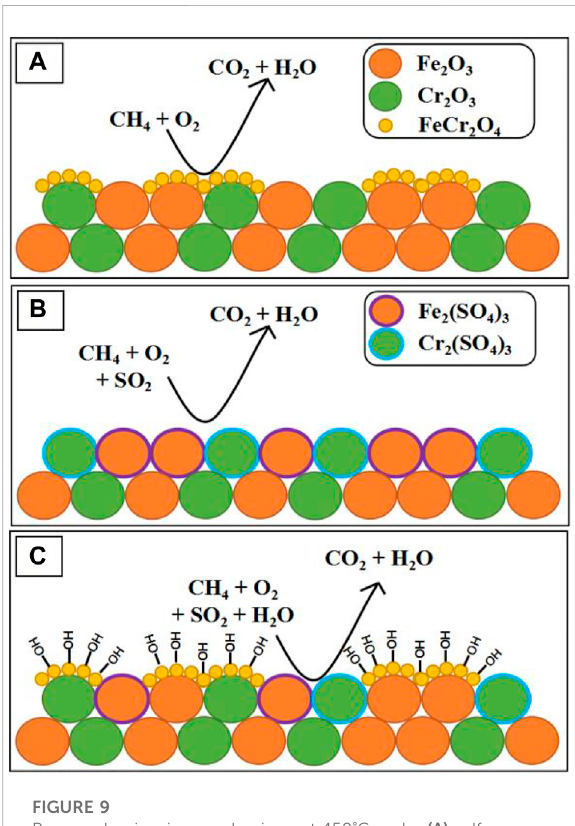
FIGURE 9 Proposed poisoning mechanisms at 450 ° C under (A) sulfur- free conditions, (B) dry conditions, and (C) wet conditions. Cited from García-Vázquez et al.